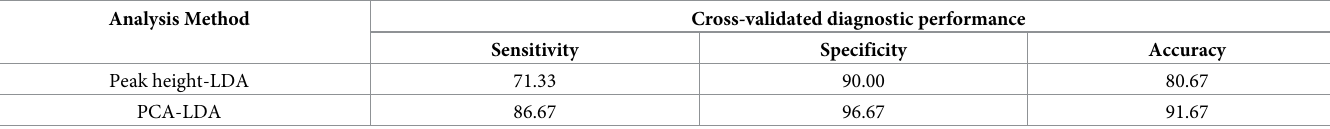
Table 2. The diagnostic performance in classification between the CCA and healthy groups using peak height-LDA and PCA-LDA methods together with a k-fold cross validation approach (k =